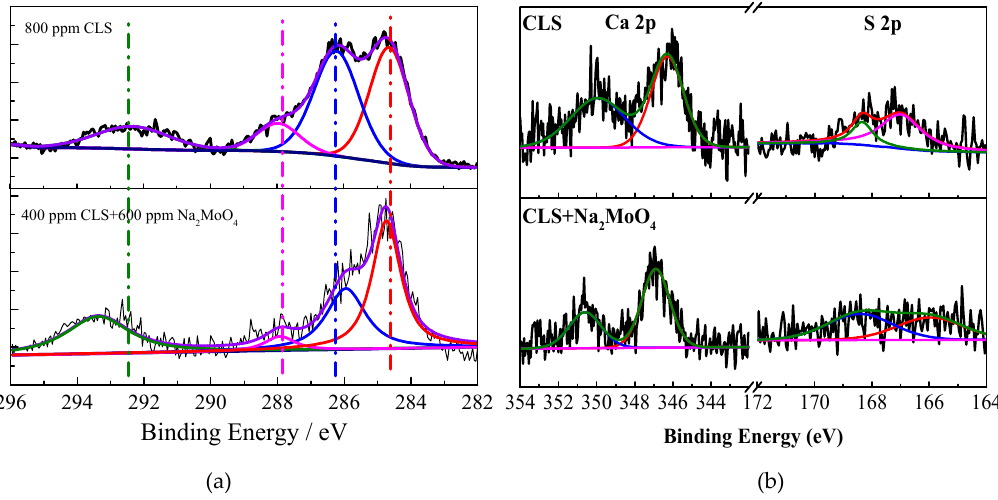
Figure 8. High-resolution XPS spectrum of Q235 steel immersed in test solution with CLS and CLS+Na 2 MoO 4 : ( a ) C 1s; ( b ) Ca 2p and S 2p.